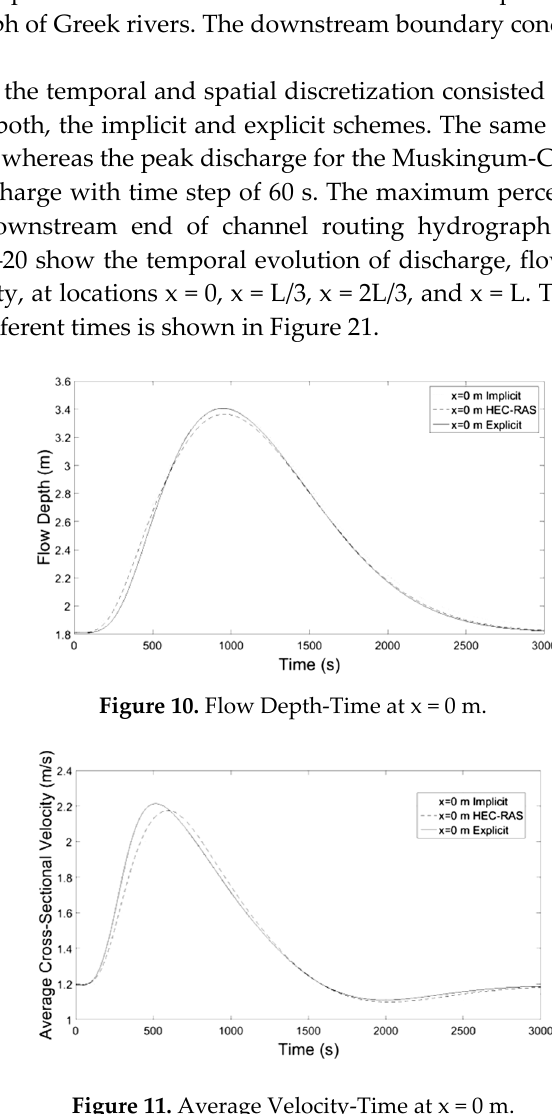
Figure 11. Average Velocity-Time at x = 0 m.